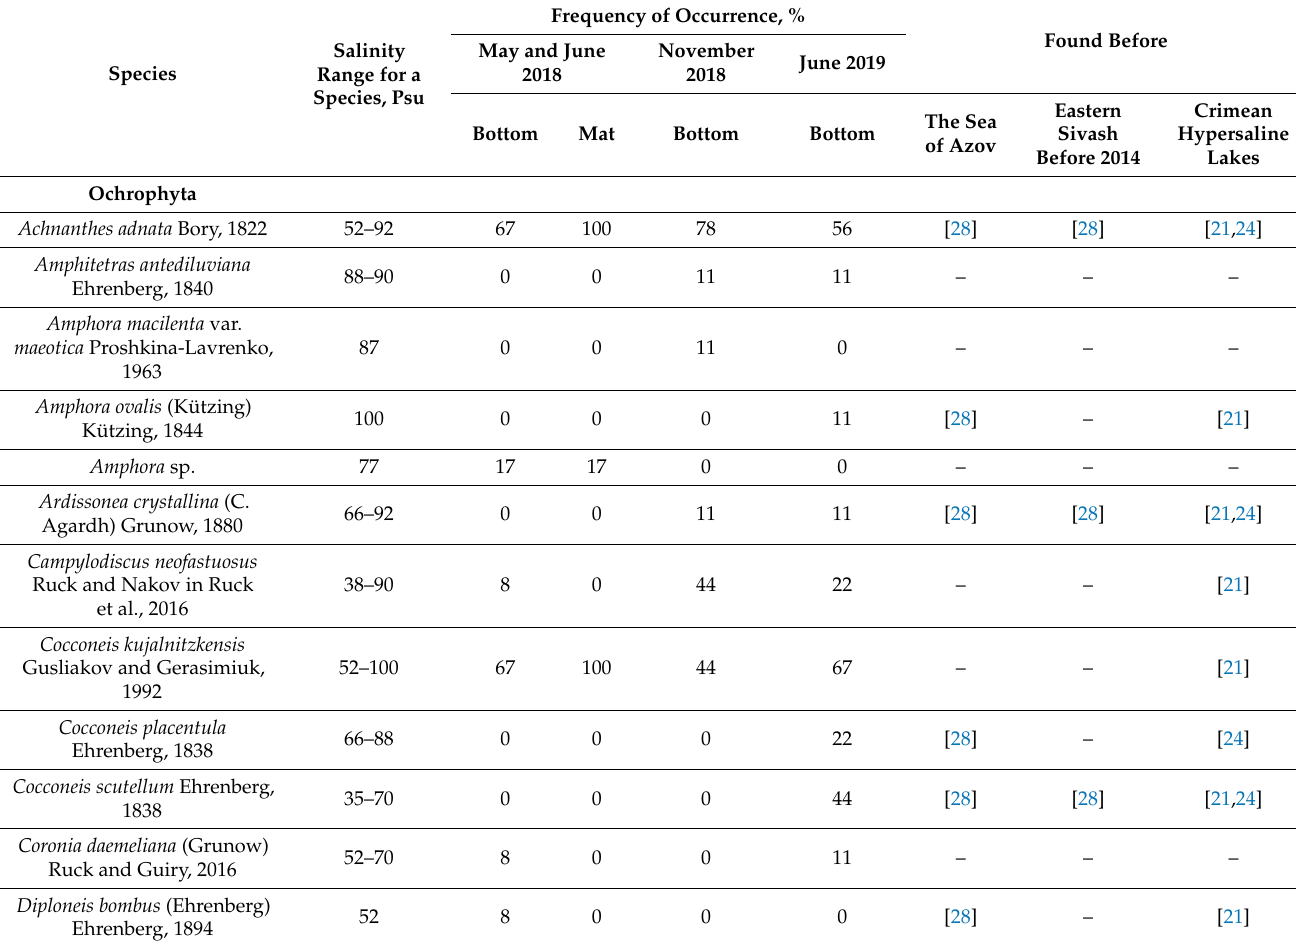
Table 2. Species composition of microphytobenthos in Bay Sivash